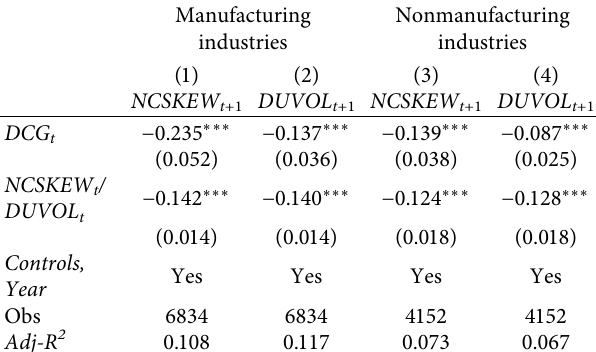
Table 4: Analysis of heterogeneity: based on industry